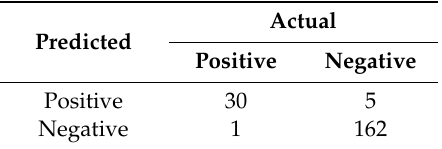
Table 8. Confusion matrix for model Msuv in an